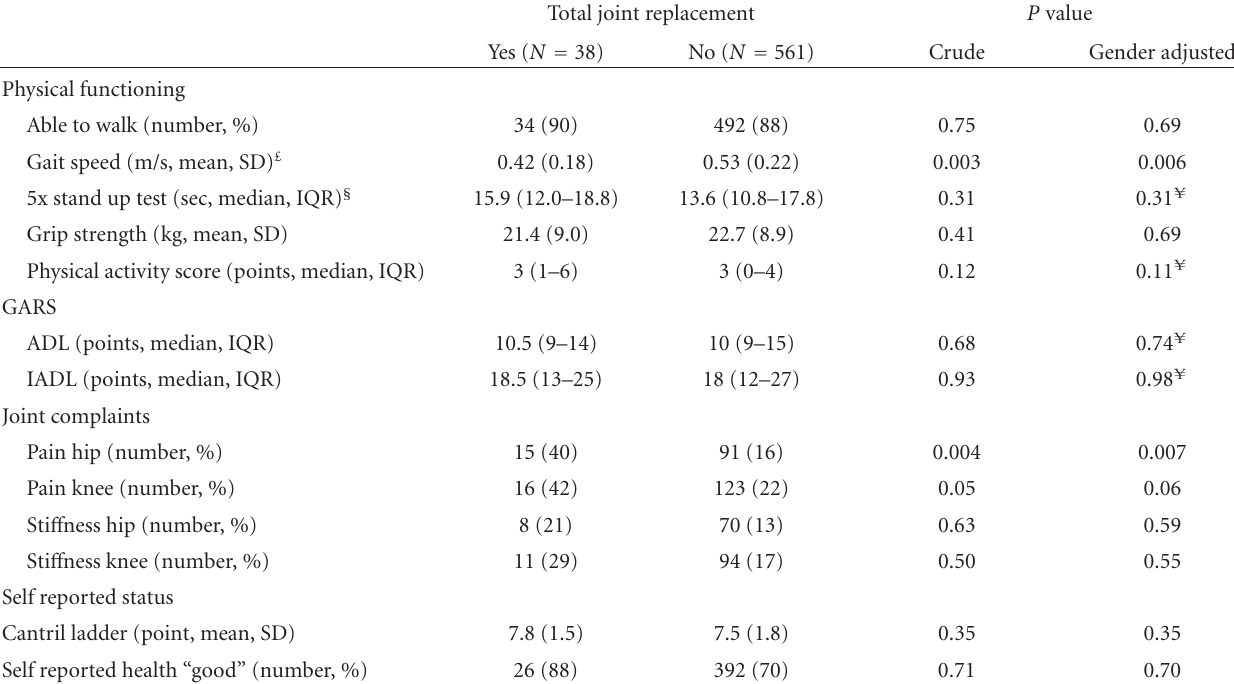
Table 2: Health and functional characteristics of participants with and without a total joint replacement in the past.